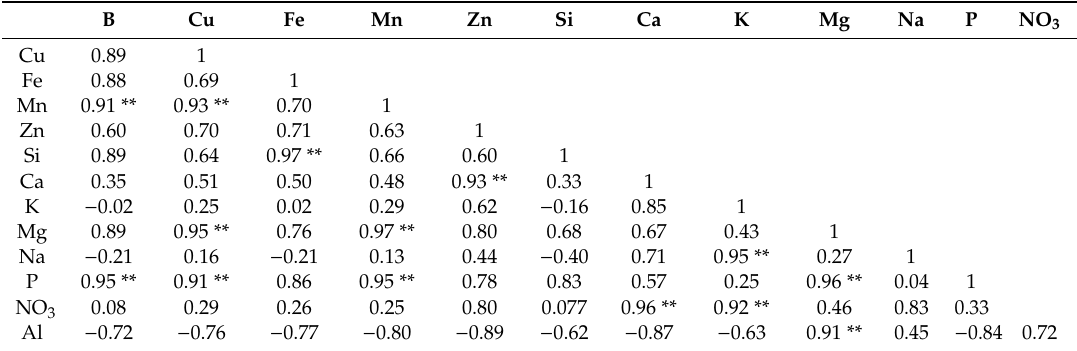
Table 7. Correlations between mineral elements in shallot